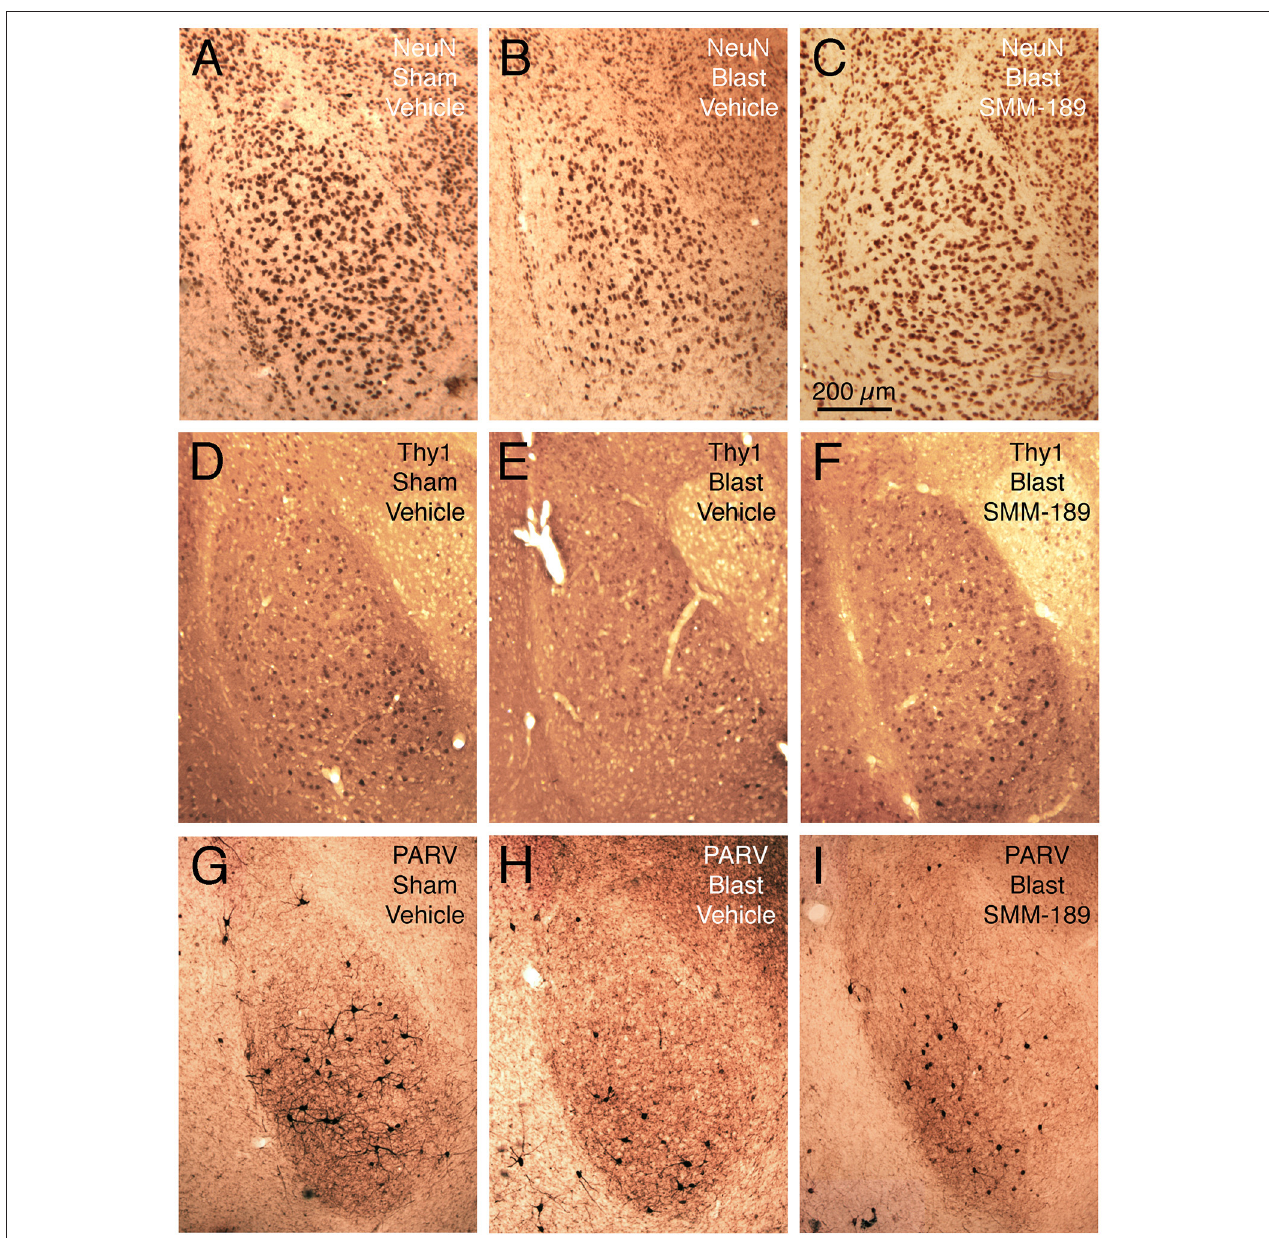
FIGURE 6 | Images showing the effect of TBI and SMM-189 on NeuN + neurons in left BLA (A–C), on Thy1 + fear-suppressing pyramidal neurons in left BLA in a Thy1-EYFP reporter mouse (D–F), and on PARV + interneurons in left BLA (G–I). A reduction in NeuN + neurons is seen in the 60-psi blast mice ( B compared to A ), which trended toward being rescued by SMM-189 treatment (C) . Similarly, Thy1 + neurons of left BLA are reduced in the 60-psi blast mice (E) , and rescued in the SMM-189 treated 60-psi blast mice (F) , as also true for the PARV + neurons of left BLA (G–I) . Medial is to the right and magnification is the same in all